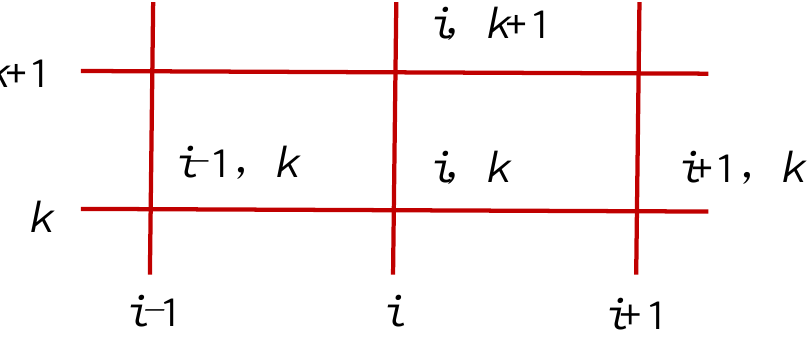
Figure 3. Grid of the finite difference method.